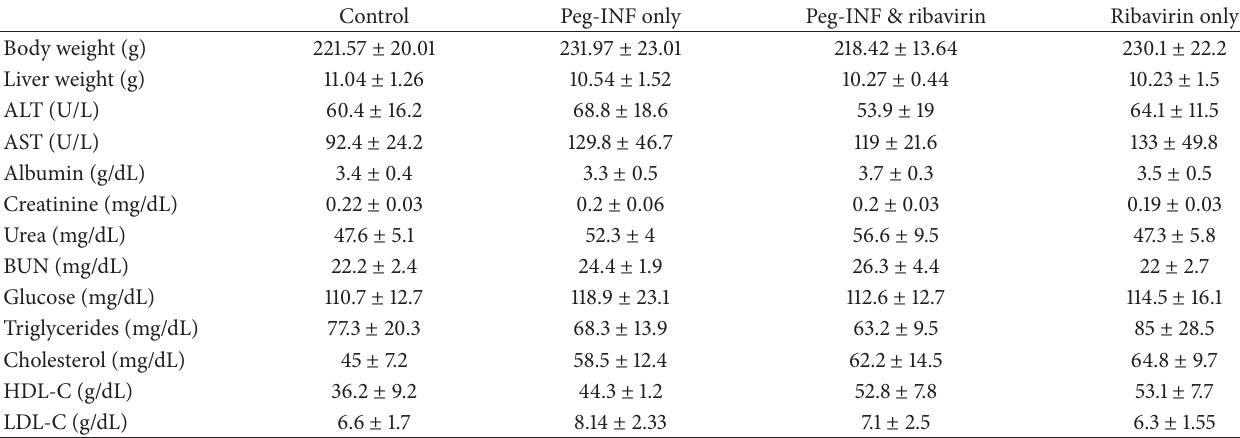
Table 2: Mean ± SD of body weight, total liver weight, liver enzymes, albumin, renal function, and metabolic parameters in the different study groups.